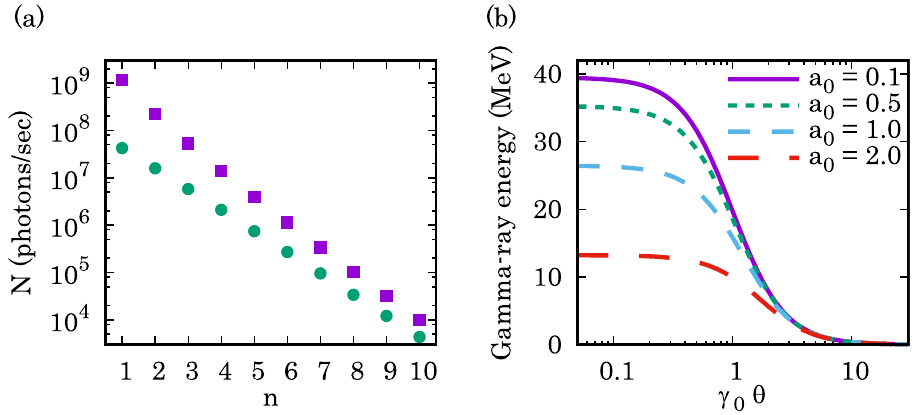
Figure 4. ( a ) Number of photons per unit time at each harmonic calculated using Eq. (36). The integration range of the scattering angle of each symbol is as follows: square, θ 1 = 0.003/ γ 0 and θ 2 = 0.6/ γ 0 ; circle, = 2.40/ γ = 2.47/ γ θ θ 1 0 and 2 0 . These regions correspond to the more than 90% of circular polarization with positive helicity carrying OAM and more than 90% of circular polarization with negative helicity carrying OAM, respectively. The calculation parameters are as follows: γ 0 = 2000, λ 0 = 1.0 μ m, a 0 = 1.0, N 0 = 500, and N e = 10 9 electrons/s. ( b ) Energy of NITS gamma-rays ( n = 2) calculated by Eq. (34). The laser strength parameters are as follows: a 0 = 0.1 (solid line), a 0 = 0.5 (short dashed line), a 0 = 1.0 (middle dashed line), and a 0 = 2.0 (long dashed line). Other calculation parameters are γ 0 = 2000 and λ 0 = 1.0 μ